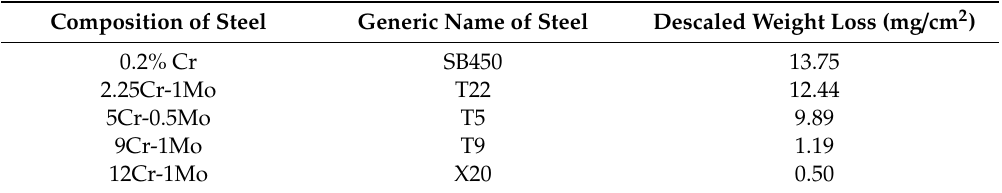
Table 1. Corrosion from descaled weight losses of steel specimens following exposure to molten salt at 550 ◦ C for 1000 h. (Adapted from